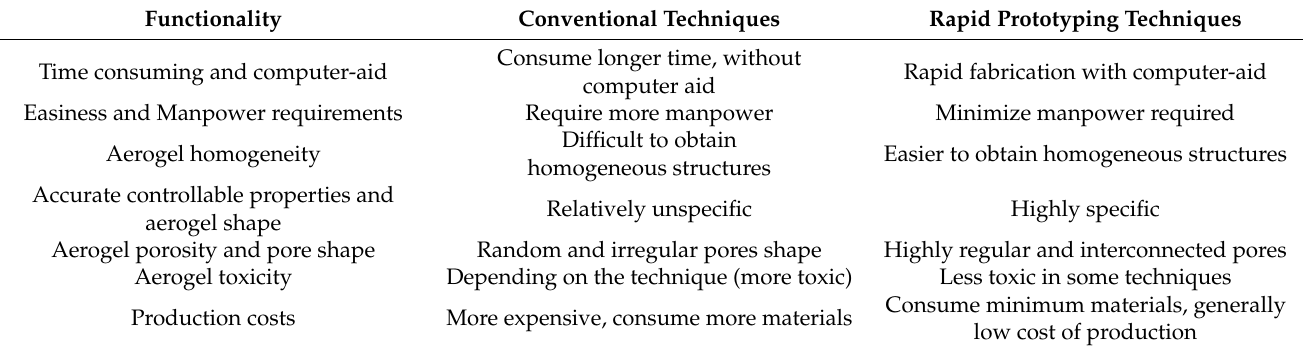
Table 2. Comparison between conventional and advanced bioaerogel fabrication techniques.